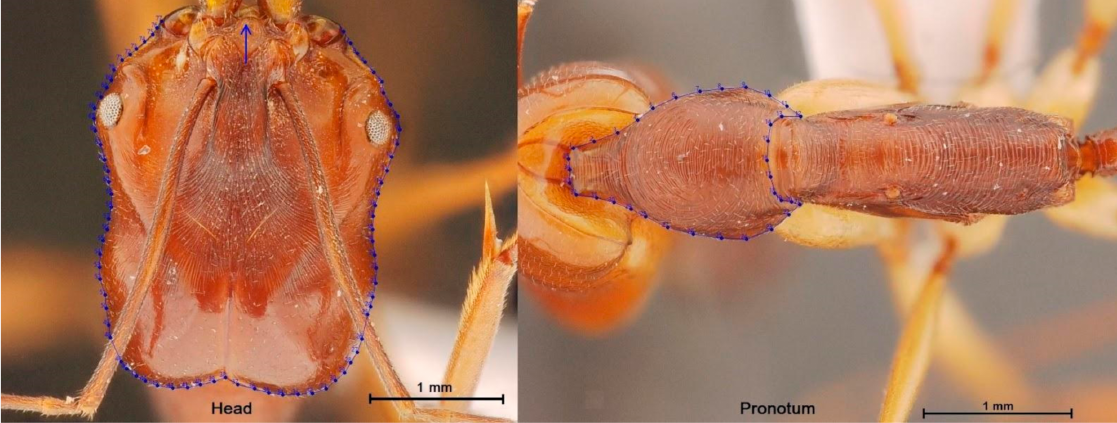
Figure 2. Pseudolandmarks (blue dots) describing the contour of the head ( left ) and of the prono- tum ( right ). The arrow on the head shows the small part of the contour that could not receive valid